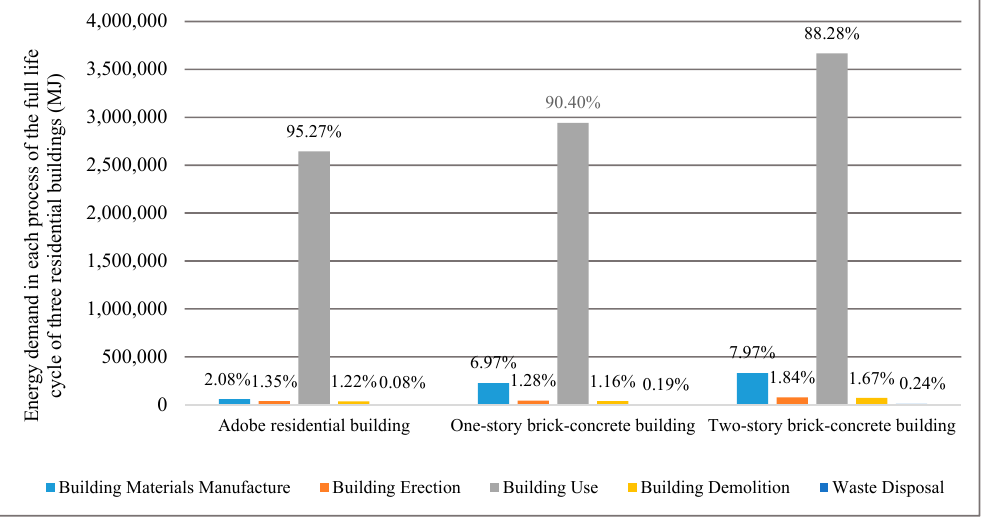
Figure 18. Energy demand in each process of the full life cycle of three residential buildings (%).